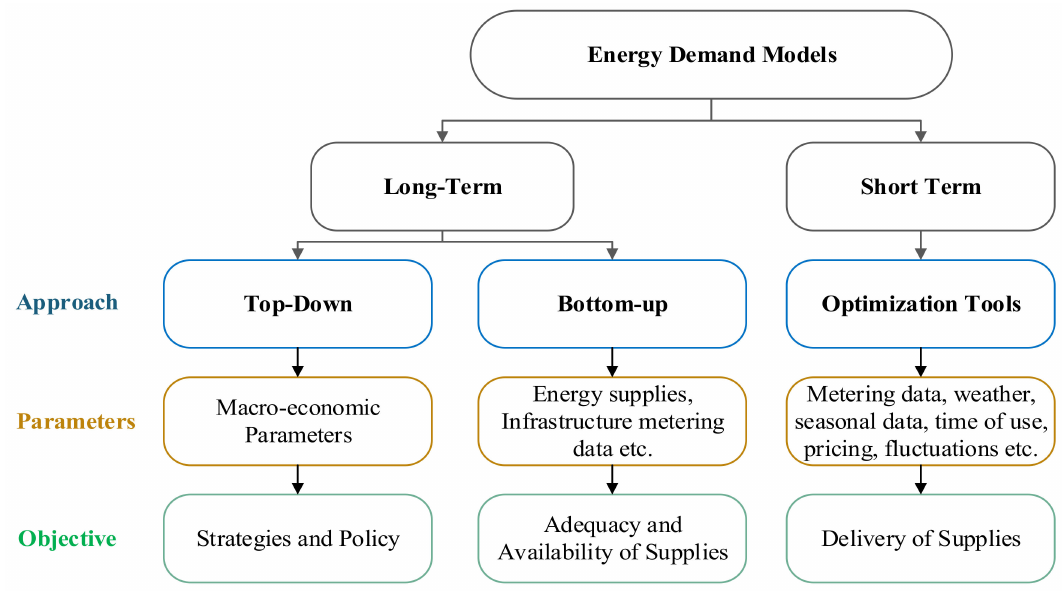
Figure 13. Energy demand modeling